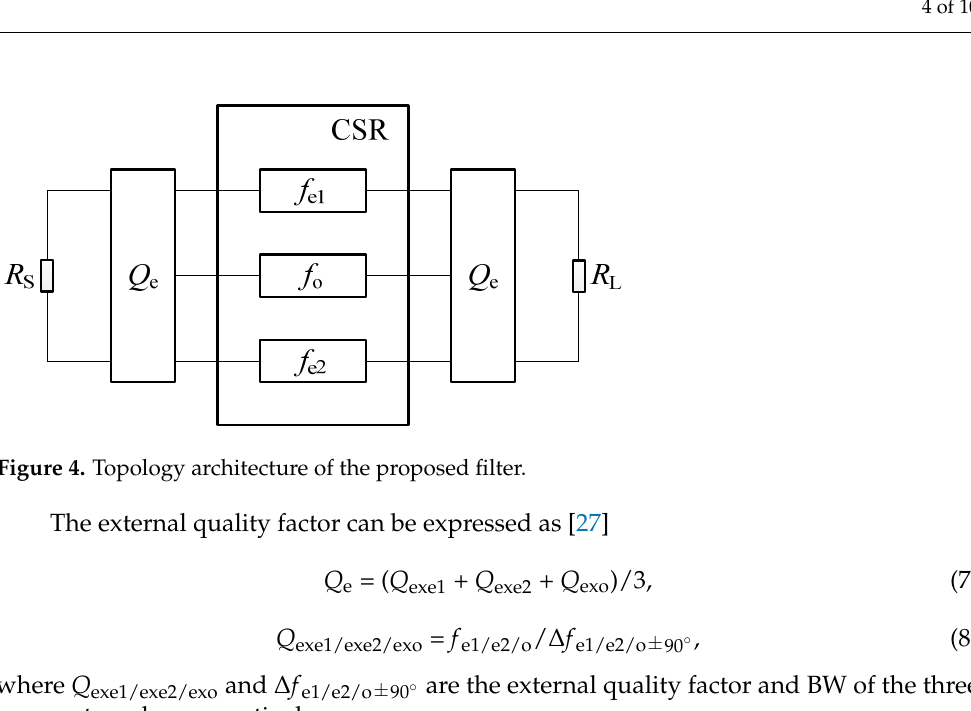
Figure 5. Theoretical curves for varying m e1e1 , m oo and m e2e2 considering a fixed Q e = 28.